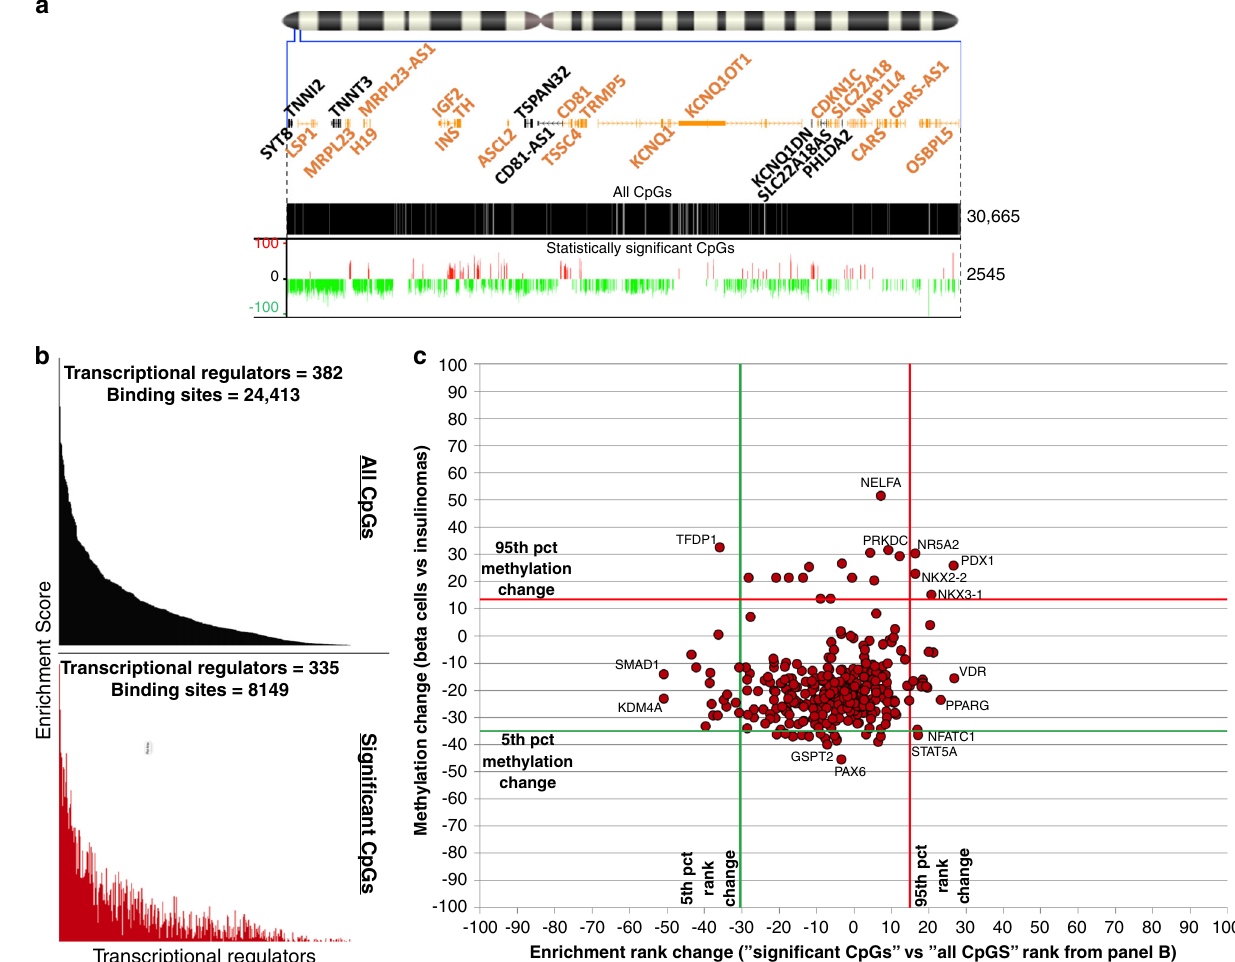
Fig. 3 Transcriptional regulator analysis for differentially methylated regions. a The chromosome 11 ideogram with a magni fi cation of the 11p15.5-p15.4 target sub-region is as described in Fig. 1a. The black track displays the distribution of all 30,665 CpG dinucleotides populating the target region. The red- green track on the bottom is the same as the bottom track in Fig. 1b, showing 2545 differentially methylated CpG dinucleotides in insulinomas vs. beta cells. b Distribution of transcriptional regulator binding sites. For both panels, the X axis represents the transcriptional regulator binding sites from the ReMap2018 database 19 carrying either CpG dinucleotides that are located in the target region (top — black graph), or CpG dinucleotides with signi fi cant differential methylation (bottom — dark red graph). Transcriptional regulator names are shown in Supplementary Data 12. Only transcriptional regulators that were expressed in either beta cells or insulinomas were considered for this analysis. The Y axis of each graph displays the enrichment score calculated as the fraction of nucleotides of each transcriptional regulator binding site covered by CpG dinucleotides. For both graphs, transcriptional regulator binding sites are displayed using the same rank as for the “ All CpGs ” . This panel illustrates the differential enrichment of transcriptional regulators between the two tracks (Supplementary Data 12). c Enrichment rank and methylation change for the transcriptional regulator binding sites. The X axis reports the enrichment rank change when comparing the baseline “ All CpGs ” and the “ Signi fi cant CpGs ” graphs of b normalized to the number of transcriptional regulators of the two curves. The Y axis reports, for each transcriptional regulator binding site, the cumulative DNA methylation, calculated by averaging the DNA methylation within each binding site, which in turn was obtained by averaging the signi fi cant differentially methylated CpG dinucleotides ( a bottom track). Red and green lines identify 5th (green) and 95th (red) percentile for rank (vertical) and methylation (horizontal) change. Remarkably, key pancreatic transcription factors such as PDX1 and NKX2-2 appear both over-enriched and hypermethylated (see Supplementary Data 13 for